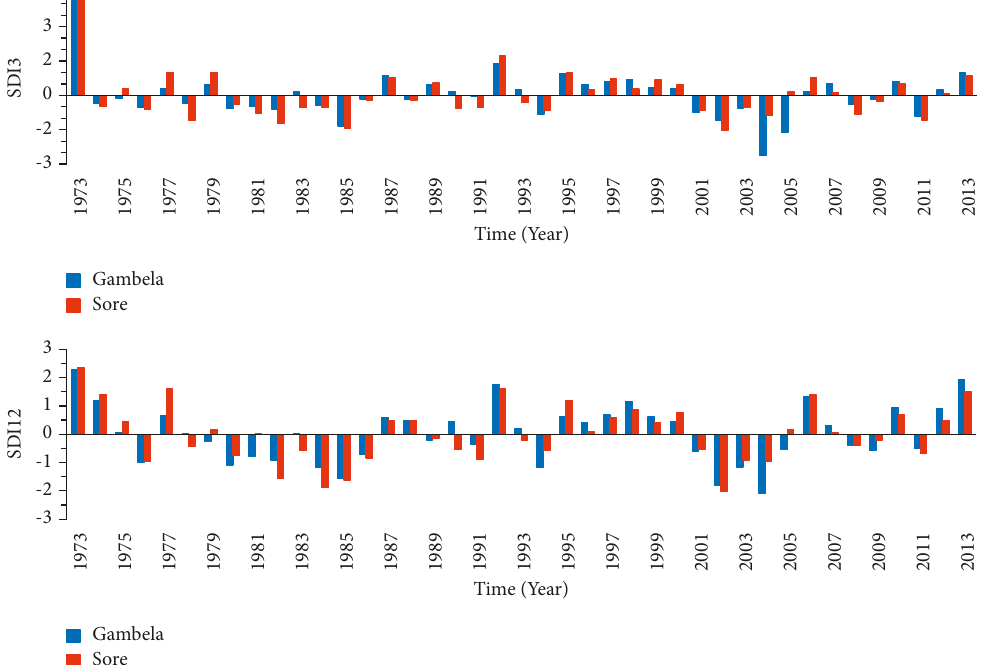
Figure 6: Temporal variation in seasonal (SDI3) and annual (SDI12) for Baro river